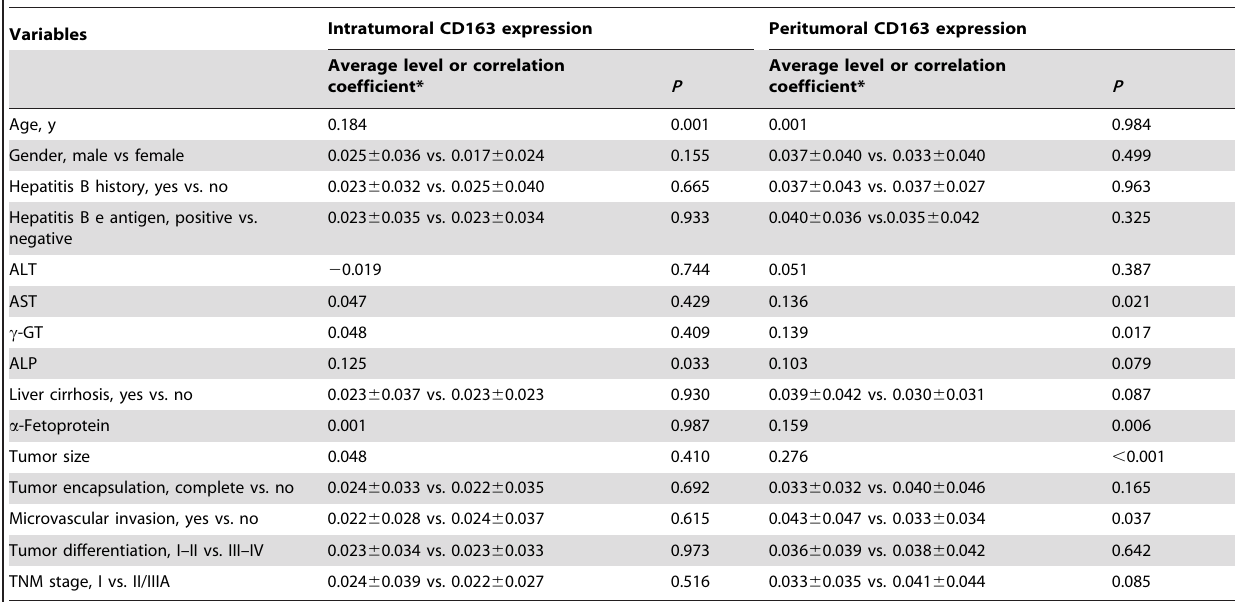
Table 2. Relationships between intratumoral/peritumoral CD163 expression and clinicopathologic features.